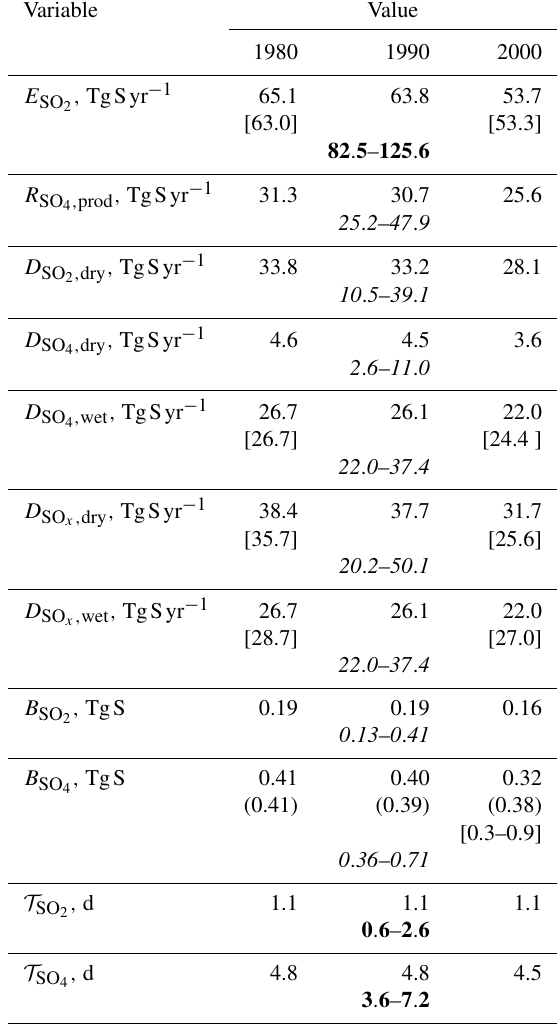
Table 2. Global sulfur budget in year 1990 as simulated by ChAP in comparison to other available estimates. The ACCMIP estimates are in square brackets and are either from Myhre et al. (2013) (their Table 4, sulfate burden) or Lamarque et al. (2013a) (emission and depositions). The values in parentheses are from the CMIP5 database (https://tntcat.iiasa.ac.at/RcpDb/, last access: 1 December 2020). Estimates in quotes are from Table 5.5 of IPCC TAR (Houghton et al., 2001) ascribed to year 1990. Bold font shows the values as they are reported in this table, and italic font is for the quantities which are rescaled by the ratio of our emissions in 1990 and the mean IPCC TAR (0 . 65 = 63 . 8 / 98 .